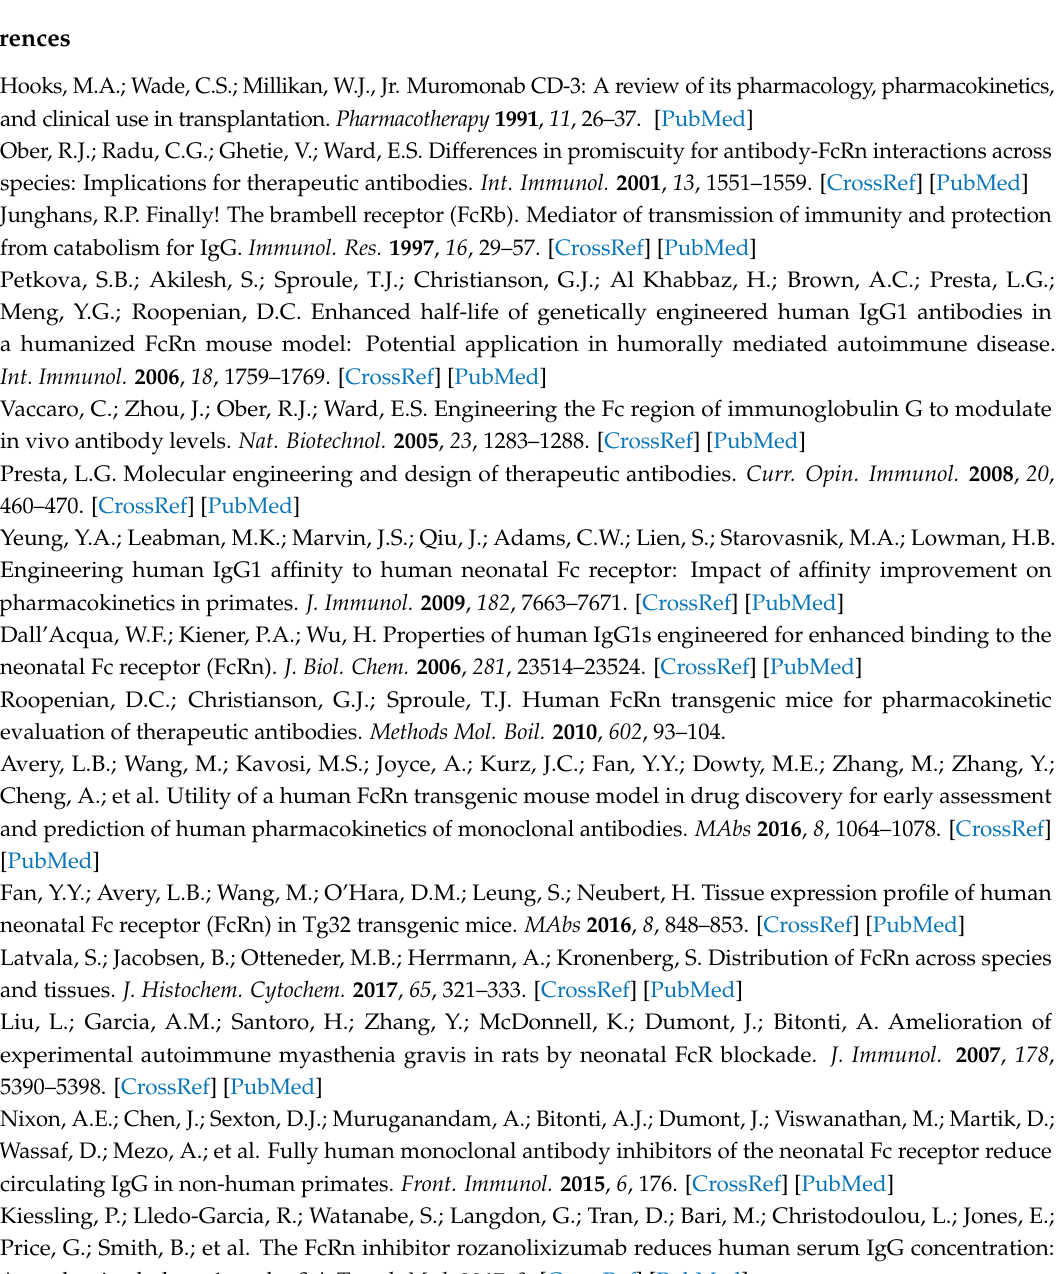
Figure S14: Representative validation of Western blot for hFcRn in transgenic mouse spleen tissue; Figure S15: Representative validation of Western blot for hFcRn in transgenic mouse heart tissue; Figure S16: Representative validation of Western blot for hFcRn in transgenic mouse kidney tissue; Figure S17: Representative validation of Western blot for hFcRn in transgenic mouse small intestine tissue; Figure S18: Representative validation of Western blot for hFcRn in transgenic mouse liver tissue; Figure S19: Representative validation of Western blot for hFcRn in transgenic mouse skin